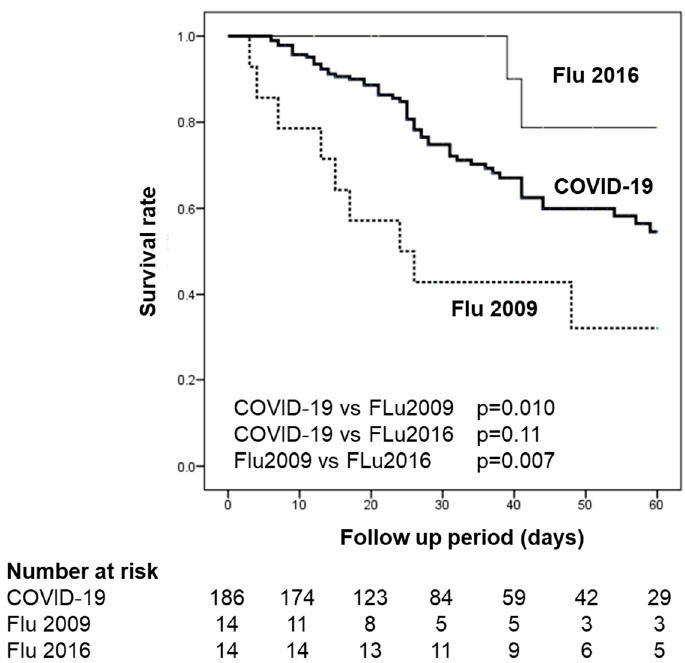
Figure 3. Kaplan–Meier survival estimates during the first 60 days of the observational study. A total of 187 patients with COVID-19 who underwent ECMO were included in this study. The COVID-19 survival curve was significantly higher than the 2009 H1N1 influenza curve ( p = 0.010), but not significantly different from the 2016 H1N1 influenza curve ( p = 0.11).